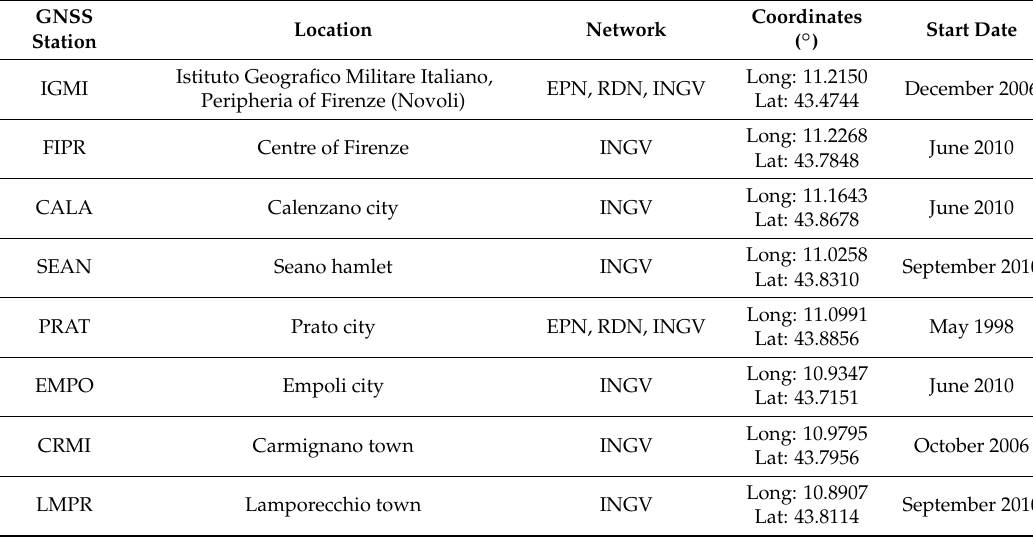
Table 2. Information about the GNSS stations in the study